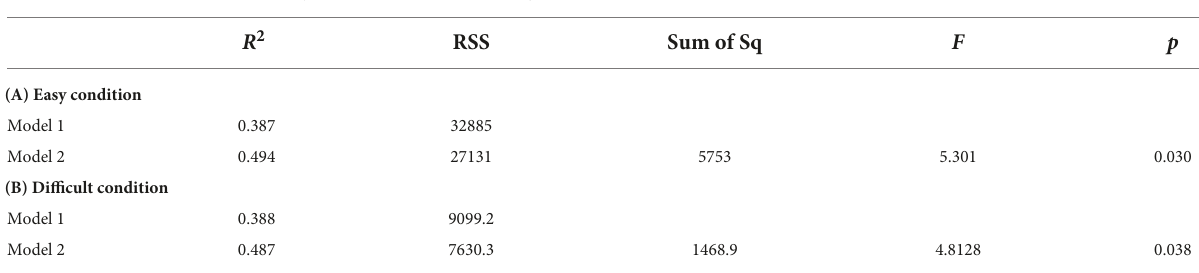
TABLE 3 Hierarchical linear regression